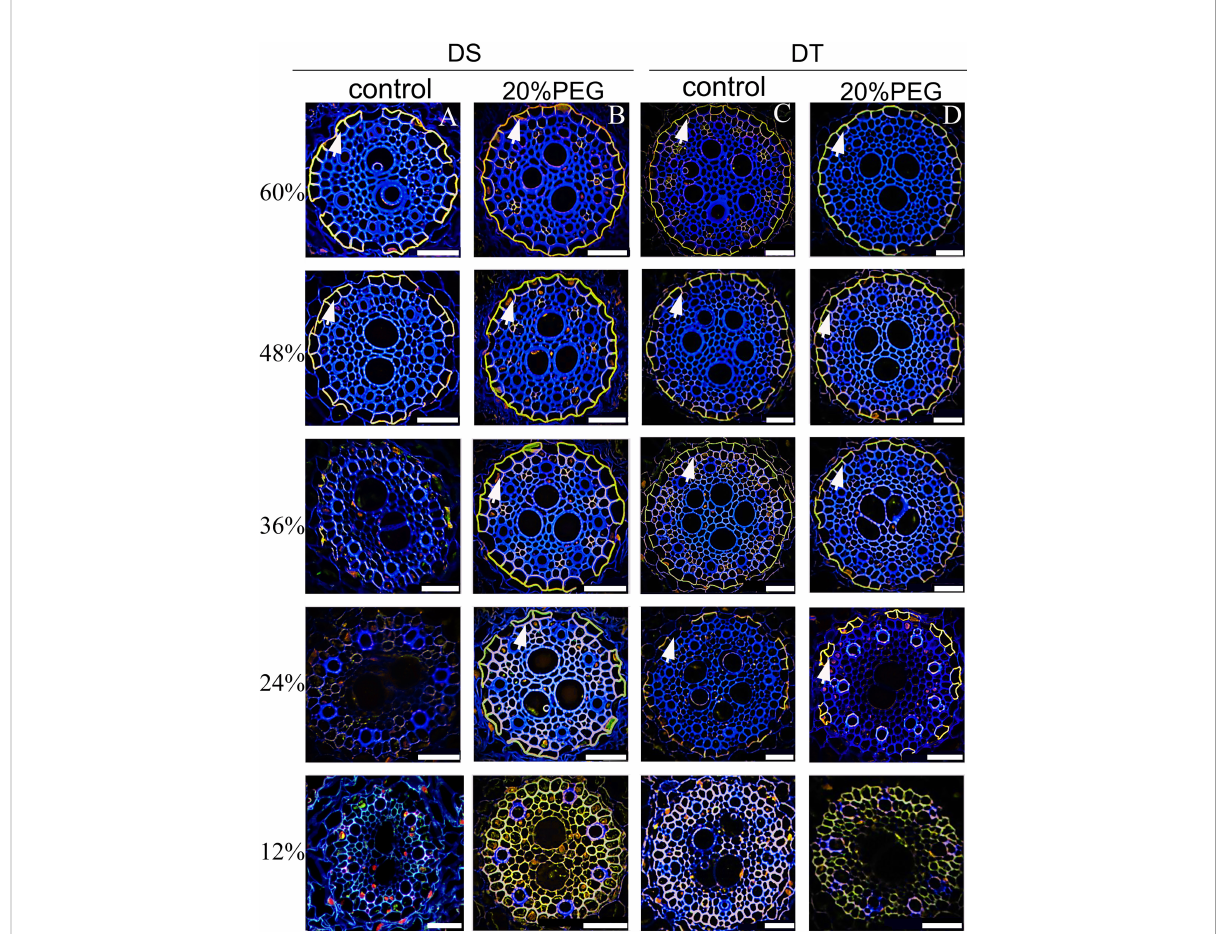
FIGURE 5 Fluorescence staining of suberin lamellae (SL) in seminal roots of drought-tolerant (DT) and drought-sensitive (DS) genotypes grown under control or osmotic stress conditions. The deposition of the SL in seminal roots was visualized by staining with Fluorol Yellow 088 for control DS (A) , osmotic-stressed DS (B) , control DS (C) , and osmotic-stressed DT (D) . The yellow fl uorescent rings (white arrow) indicate the SL. Numbers on the vertical axis represent the distance from the tip as a percentage of the total root length (scale bars, 42.5